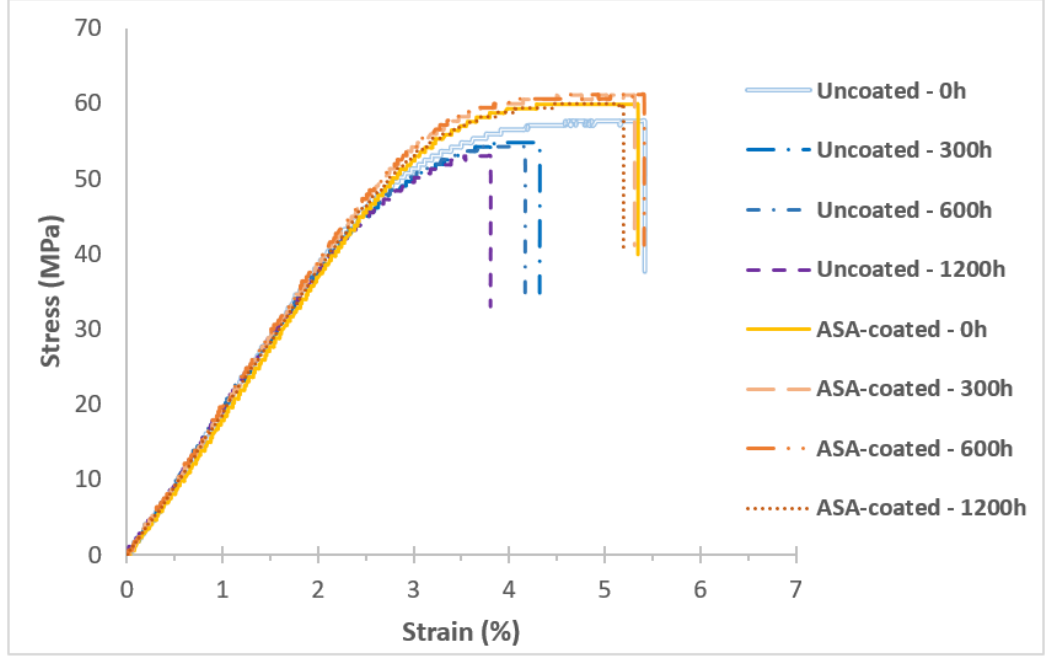
Figure 7. The average stress-strain curves of uncoated and ASA-coated 3D printed ABS specimens after 0, 300, 600, and 1200 h of environmental exposure to UV radiation and moisture.